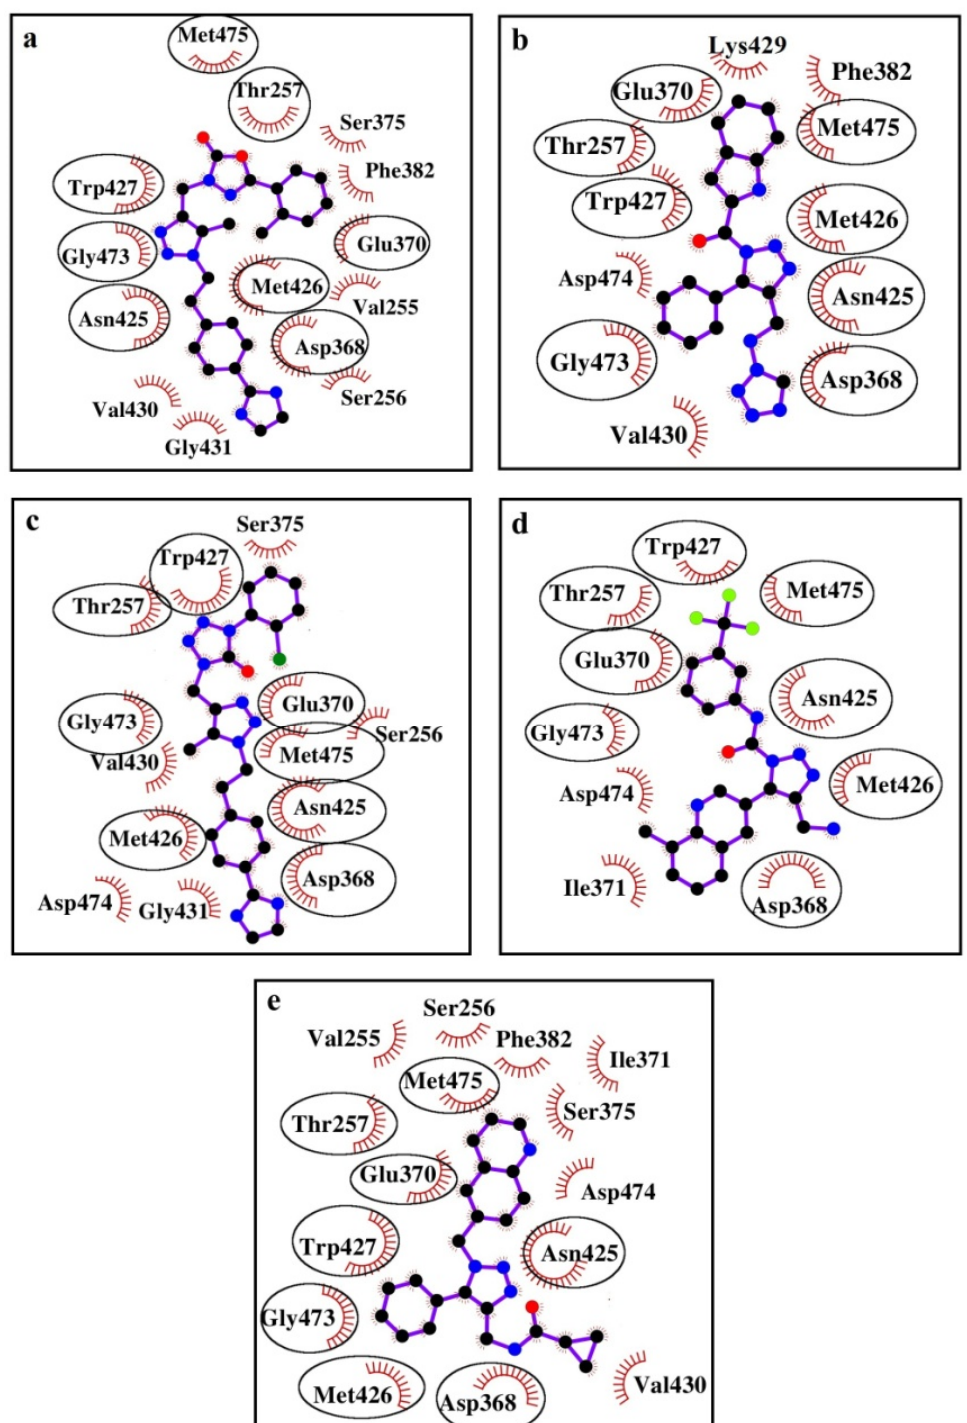
Figure 6. The gp120 residues making van der Waals contacts with compounds I ( a ), II ( b ), III ( c ), IV ( d ), and V ( e ). Residues involved in van der Waals interactions in all of the cases of interest are marked by circles. The total number of van der Waals contacts is: 80 ( a ), 66 ( b ), 70 ( c ), 61 ( d ), and 80 ( e ).